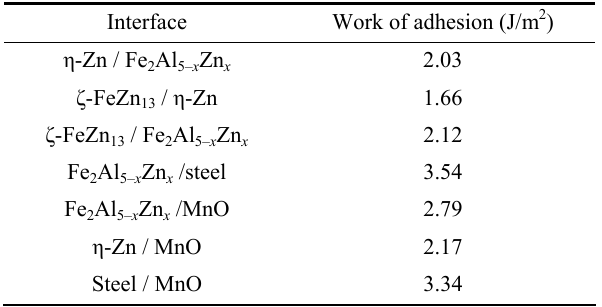
Fig. 12 Scanning electron micrographs of galvanized zinc coating on dual phase steel showing (a) fracture after 4% tensile strain, and (b) partial delamination after 13% tensile strain. Reproduced with permission from Ref. [82], © Elsevier, 2012. Table 3 Predicted work of adhesion at various interfaces in galvanized dual phase